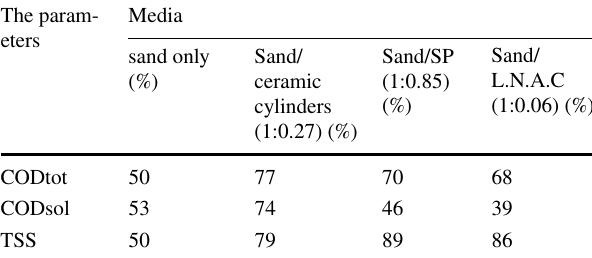
Table 5 Comparison among different media mixed with sand The param-